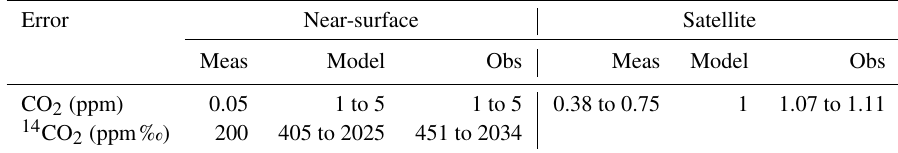
Table 5. Data, model, and observation operator 1 σ uncertainty.